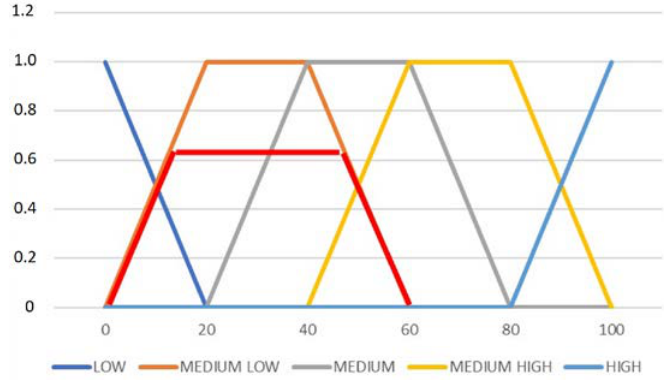
Figure 14. Aggregation of rules for machining technology 1.